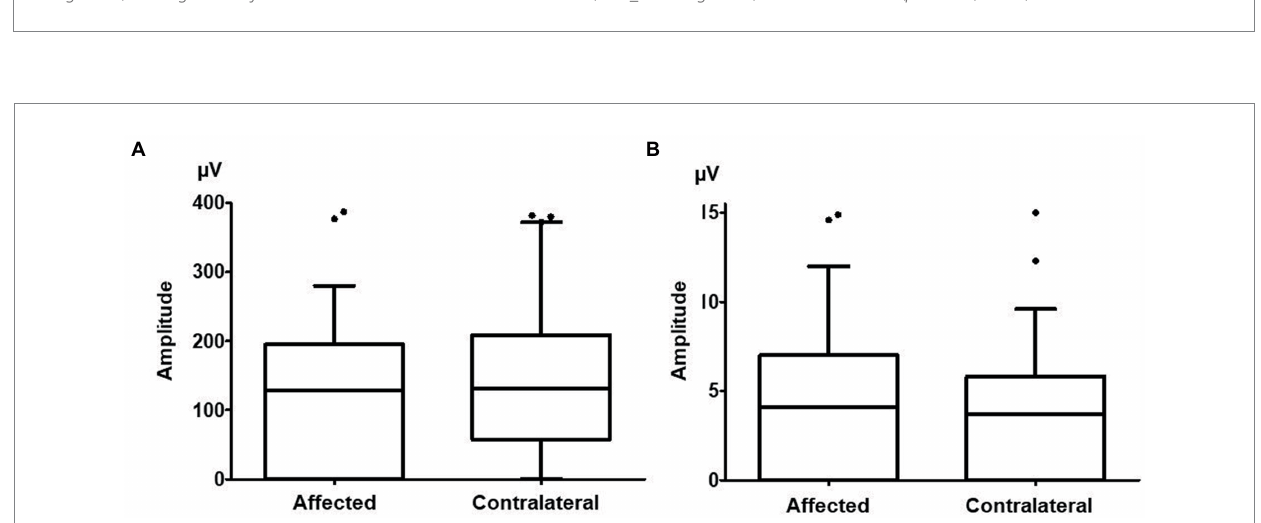
FIGURE 3 The cervical vestibular evoked myogenic potential (cVEMP) and ocular vestibular evoked myogenic potential (oVEMP) amplitudes on the affected side and contralateral side. (A) There were no significant differences between the amplitude of cVEMPs on the affected side (137.4 ± 130.3 μ V) and that on the contralateral side (153.9 ± 148.6 μ V, p = 0.096). (B) There were no significant differences between the amplitude of oVEMPs on the affected side (5.2 ± 8.2 μ V) and that on the contralateral side (5.0 ± 7.3 μ V, p = 0.770).